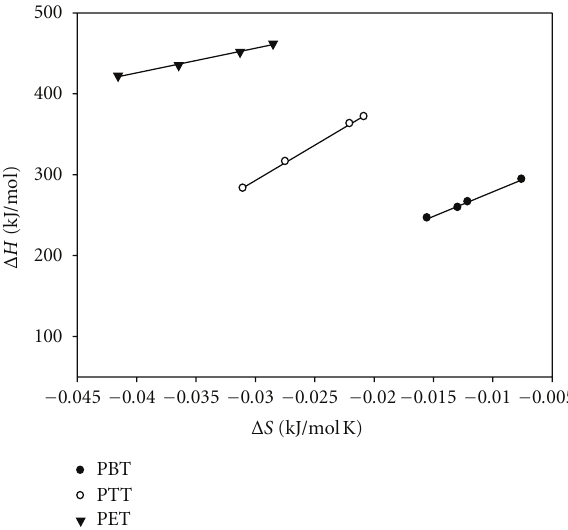
Figure 10: Plot of change in enthalpy as a function of change in entropy for the degradation of di ff erent polyesters in N 2 atmosphere (zone 2).